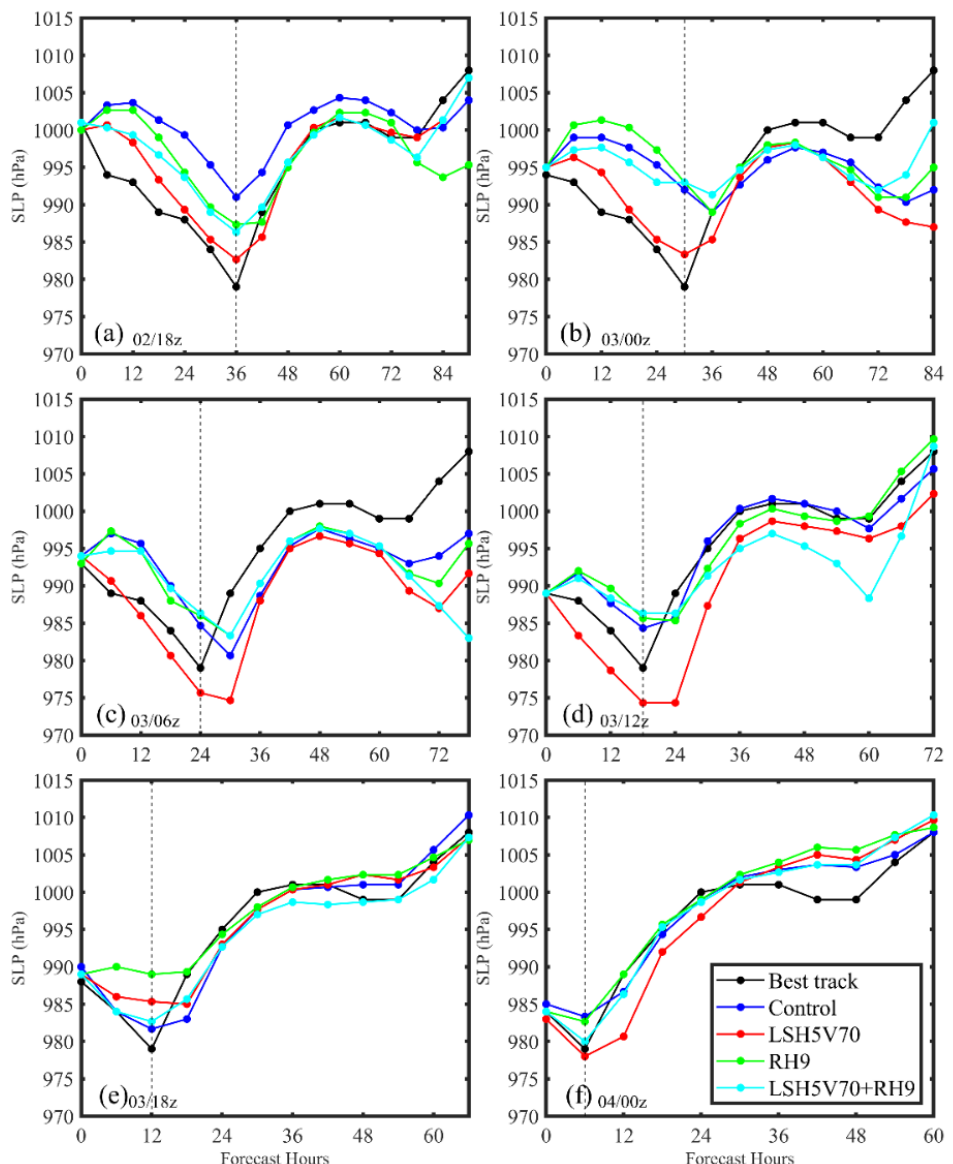
Figure 11. Comparison of the forecast SLP for Hurricane Earl from Control, LSH5V70, RH9, and LSH5V70 + RH9 at ( a ) 18 UTC 2, ( b ) 00 UTC 3, ( c ) 06 UTC 3, ( d ) 12 UTC 3, ( e ) 18 UTC 3, and ( f ) 00 UTC 4 August 2016.